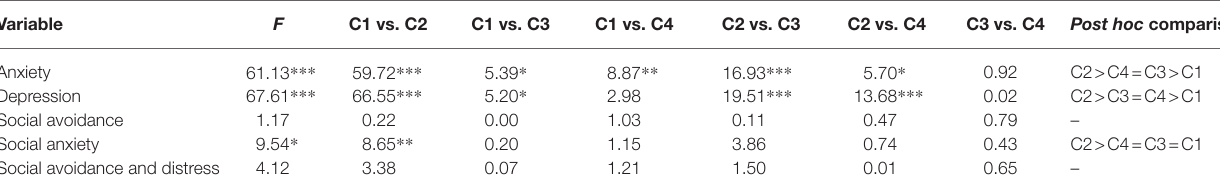
TABLE 6 | Different tests of the mental health status of graduate students in various latent classes. Variable